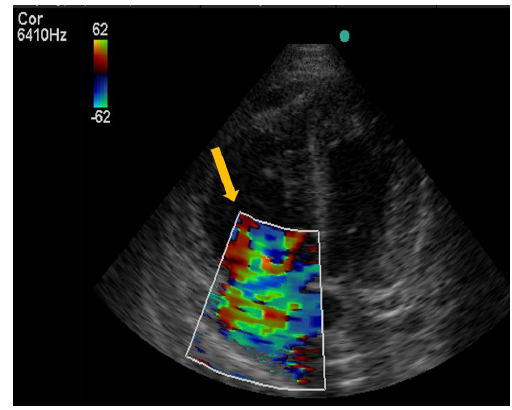
Figure 1. Echocardiographic image in the apical four-chamber parasternal view, showing presence of severe tricuspid